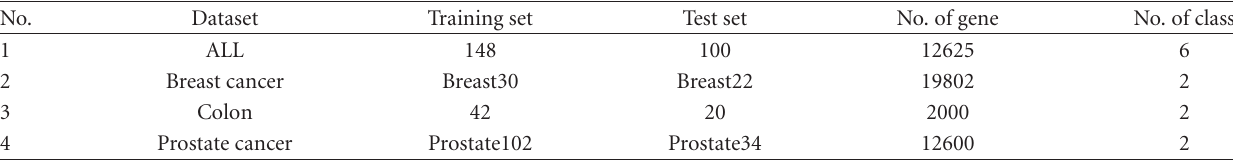
Table 1: The division of training set and test set in our